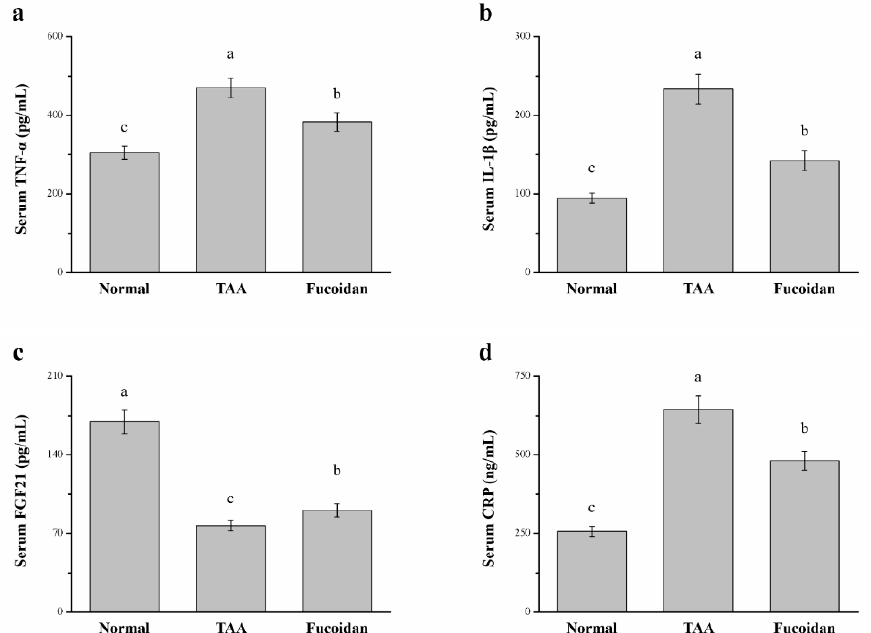
Figure 5. Changes of the serum ( a ) tumor necrosis factor- α (TNF- α ), ( b ) interleukin-1 β (IL-1 β ), ( c ) fibroblast growth factor-21 (FGF21), and ( d ) C-reactive protein (CRP) levels in normal mice, mice with TAA-induced liver injury, and fucoidan-treated mice with TAA-induced liver injury after 42 days. All data are presented as the means ± SEMs ( n = 10). a–c Data with different letters in the columns are significantly different with one-way ANOVA, and the means of different groups were compared by Duncan’s test at p < 0.05.